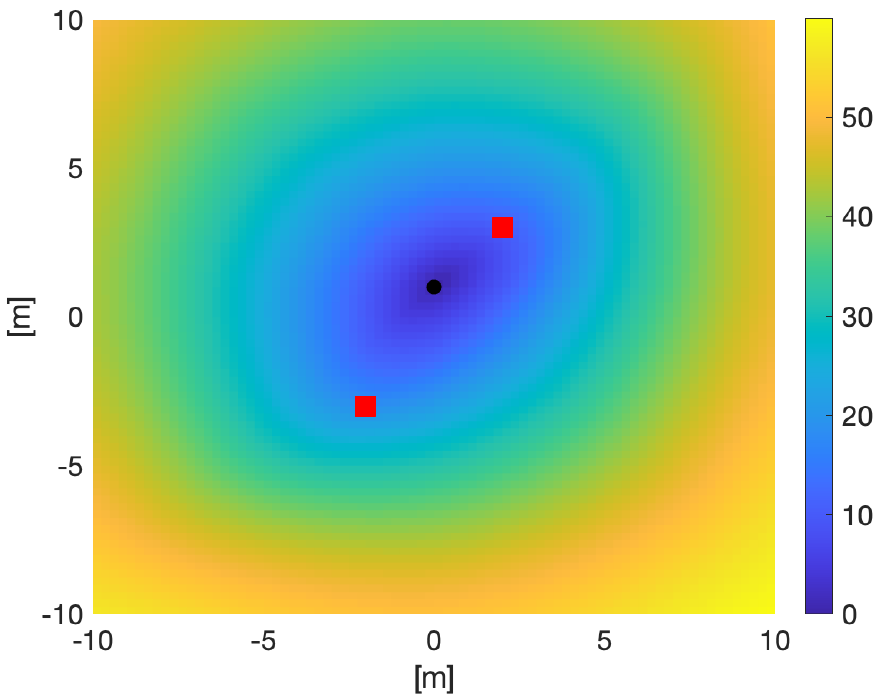
Figure 8. Geodesic distance on Ω = [ − 10,10 ] × [ − 10,10 ] for a sensor starting at ( 0,1 ) with the other sensor stationary at ( − 7, − 6 ) (raised at a height 1 above Ω ) and the using an uninformative prior for the target. The distance was calculated using a Fast Marching formulation of the geodesic equation. The fact that the geodesics follow the gradient of this distrance allows comparison with Figure 7.